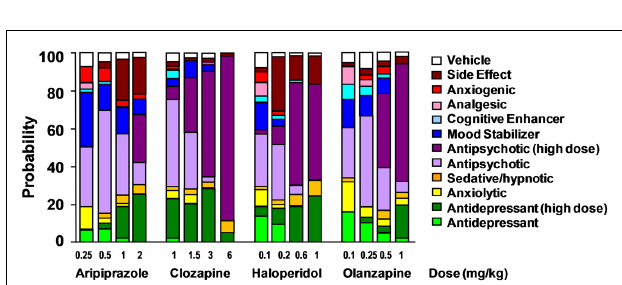
FIGURE 2 |The PDE10A inhibitorTP-10 produced a signature of activity suggesting potential antipsychotic activity. The size of a given colored region on each bar indicates the probability that the activity ofTP-10 at that dose matches a given class of neuropharmacological agents.The size of the white area represents that probability that the activity is more similar to that of the vehicle rather than to that of any compounds in the reference database.The drug was injected i.p., 15min before testing.